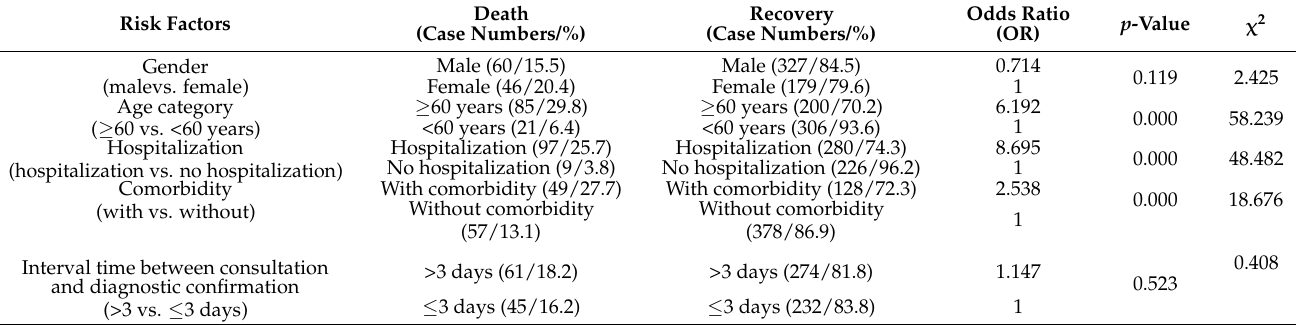
Table 2. Relationship between the COVID-19 disease evolution and the risk factors (N =